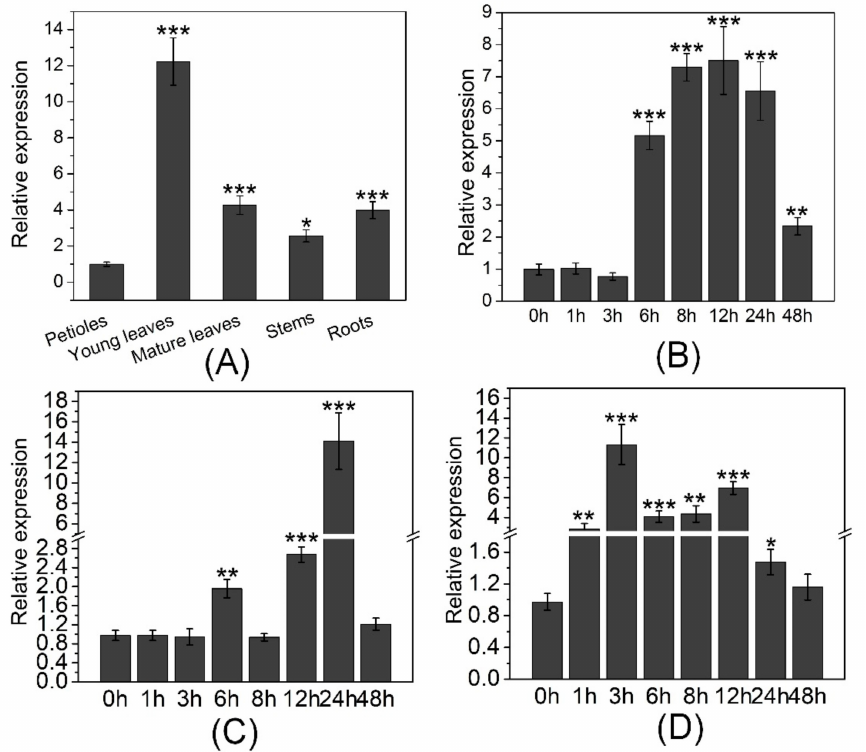
Figure 3. The identification of PtOSH1 mRNA expression level based on the quantitative reverse transcription polymerase chain reaction (qRT-PCR). ( A ) The mRNA transcript levels of PtOSH1 in various tissues. ( B ) The mRNA transcript level of PtOSH1 in response to Cd stress. ( C ) The mRNA transcript level of PtOSH1 in response to ABA stress. ( D ) The mRNA transcript level of PtOSH1 in response to H 2 O 2 stress. Three independent biological experiments were performed with three technical repeats. One-way analysis of variance (ANOVA) and Tukey’s test were used to evaluate significant di ff erences. Data are 2 – ∆∆ Ct levels relative to the petiole and normalized to that of PtActin . Vertical bars represent the means ± standard deviation (SD, n = 3). *, Significant di ff erence at p < 0.05; **, Significant di ff erence at p < 0.01; ***, significant di ff erence at p <